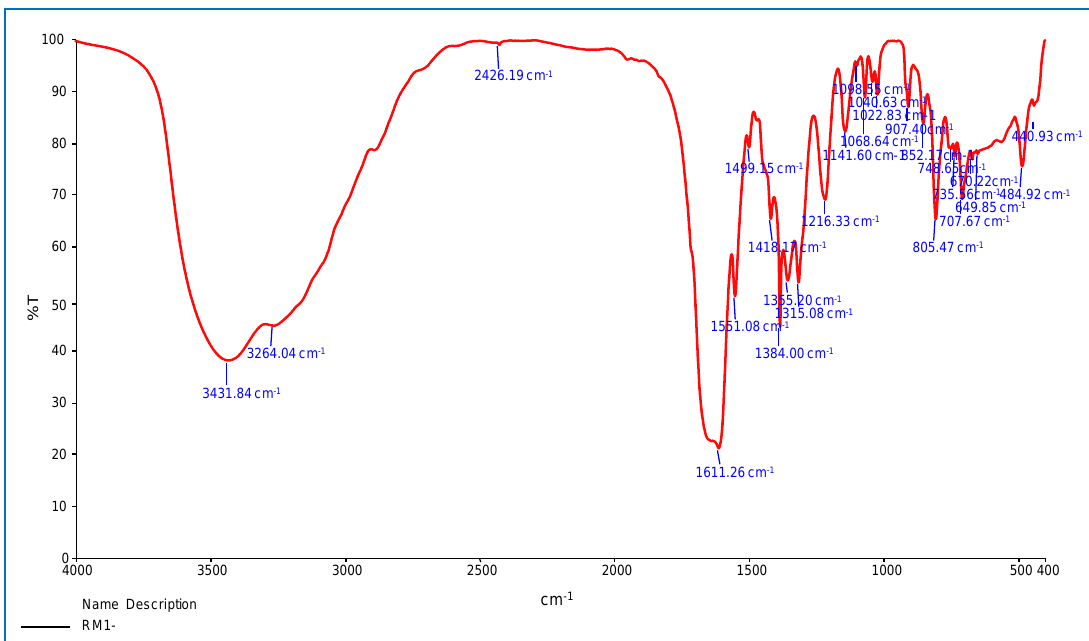
Figure 4. FT-IR spectrum of Co(II) mixed ligands complex.